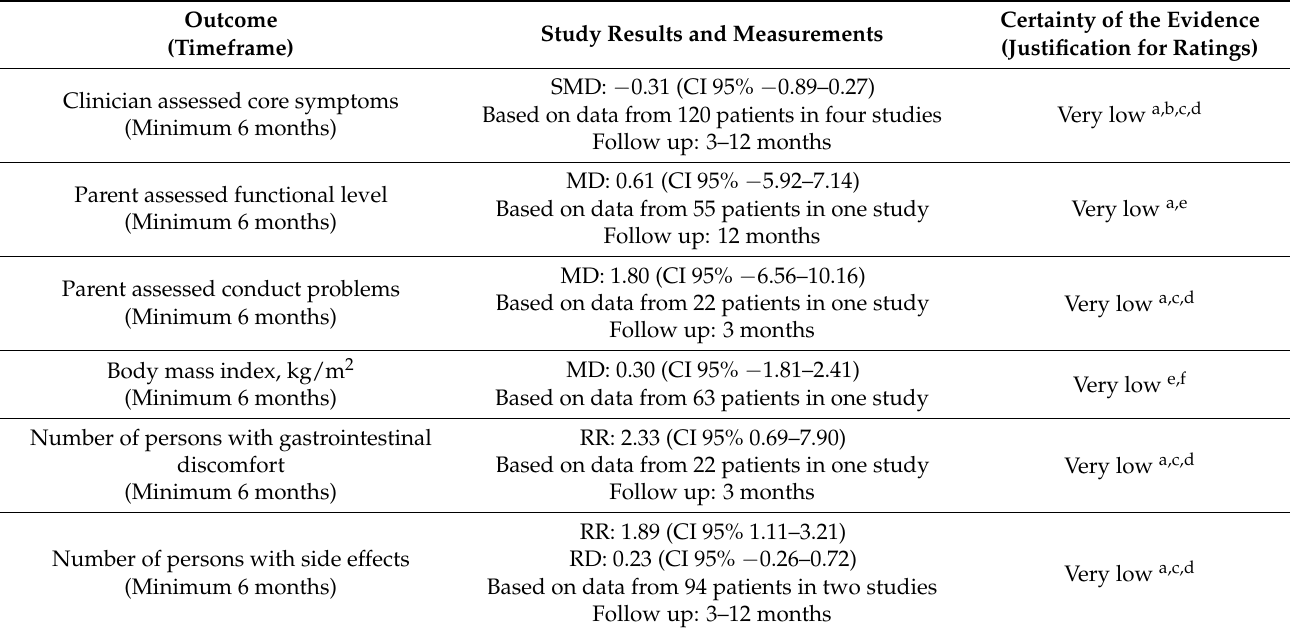
Table 4. Summary of findings on GFCF versus usual